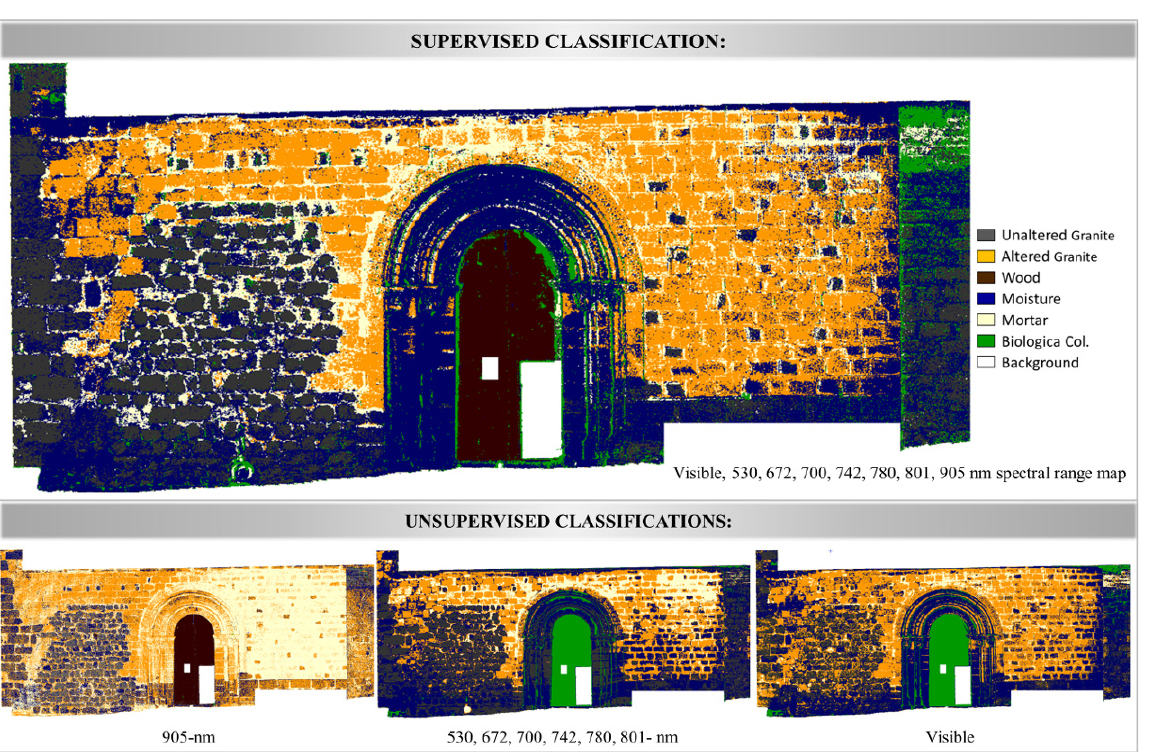
Table 3. Transformed divergence for the supervised classification.